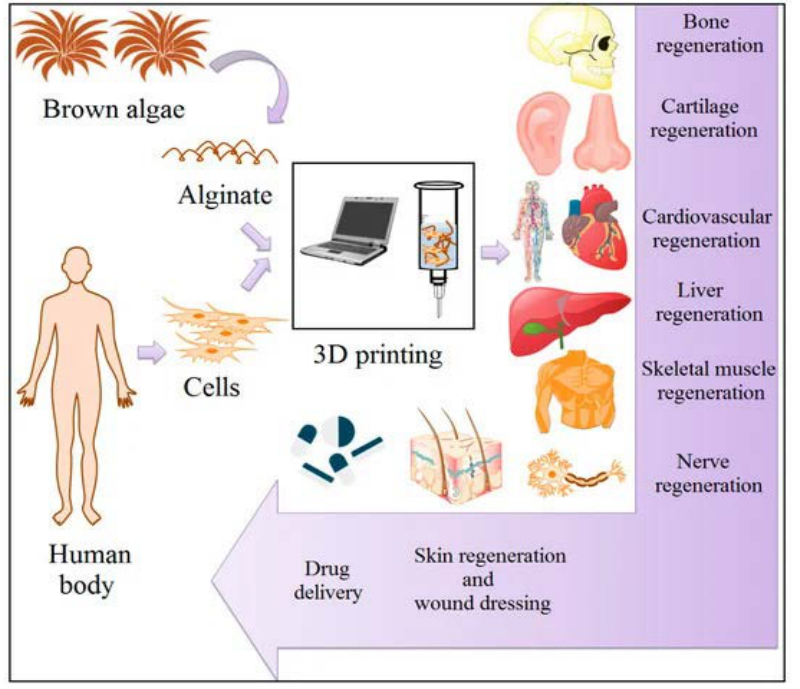
Figure 3. Three-dimensional alginate hydrogels in tissue engineering applications [60].